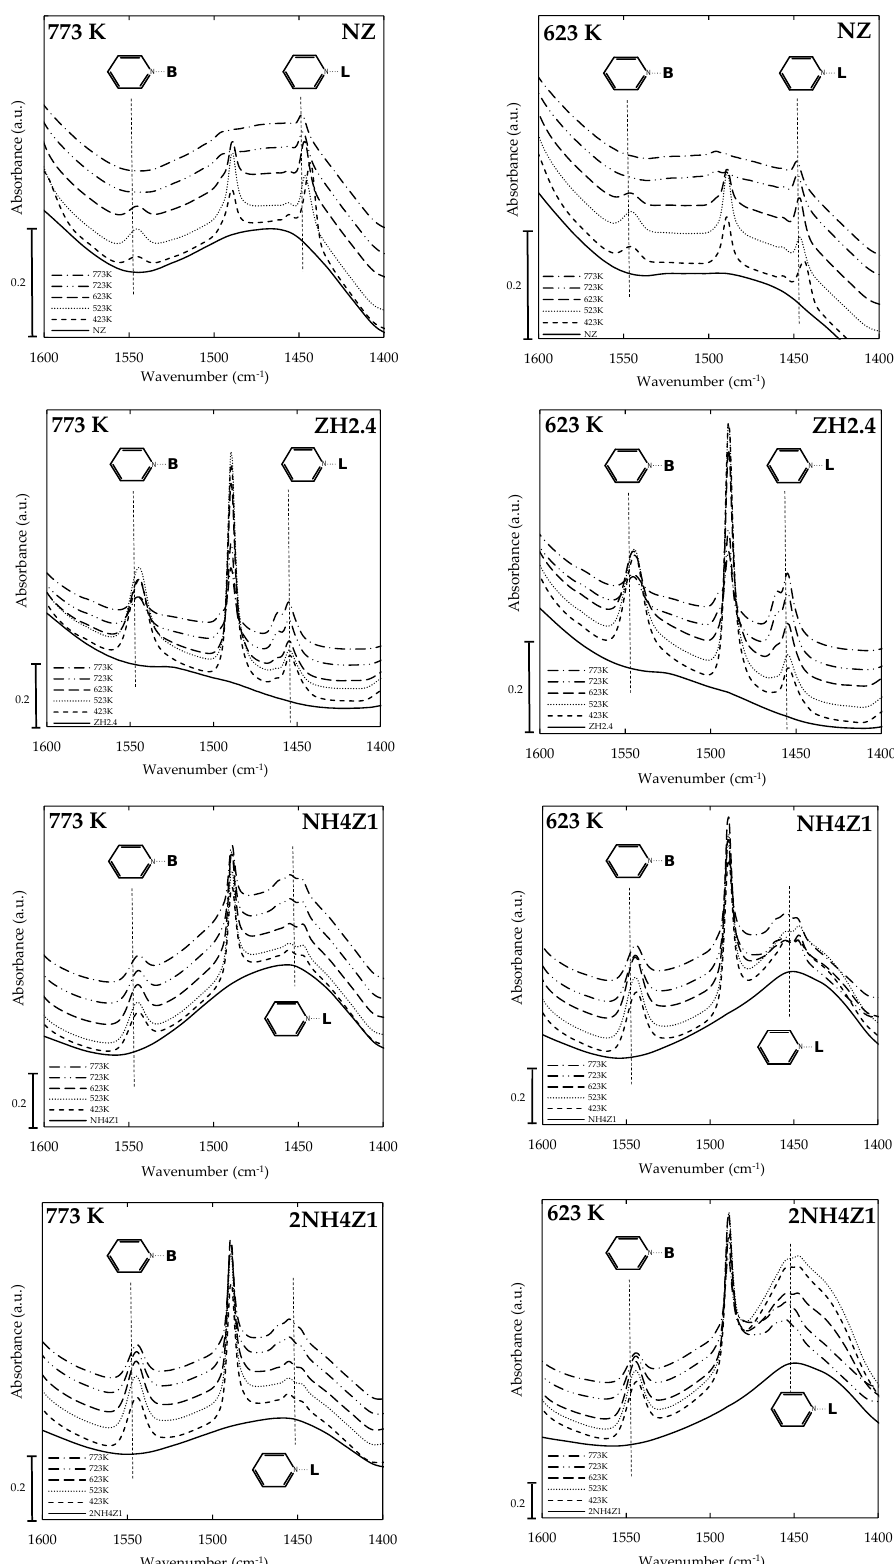
Figure 1. FTIR spectra of pyridine-saturated natural and modified zeolite samples.